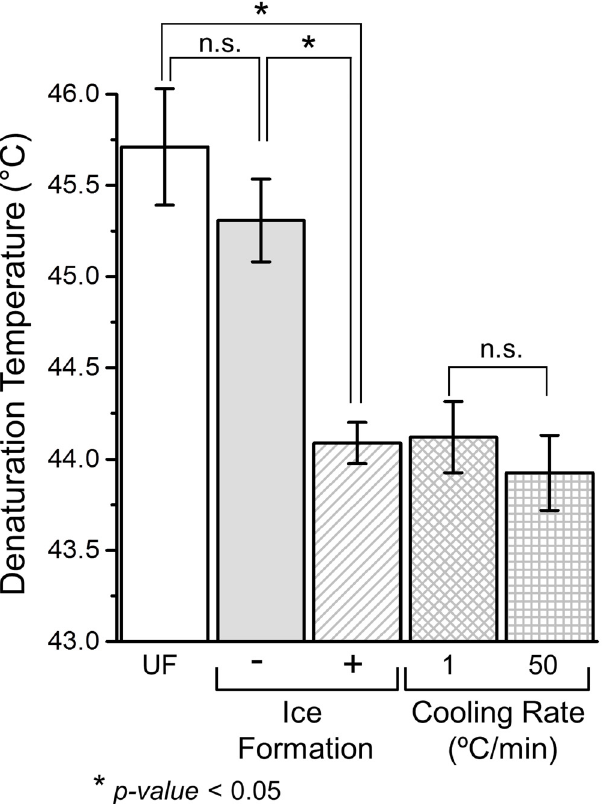
Fig 3. Effects of F/T conditions on post-thaw denaturation temperature. ‘ * ’ indicates significant difference ( p < 0.05).